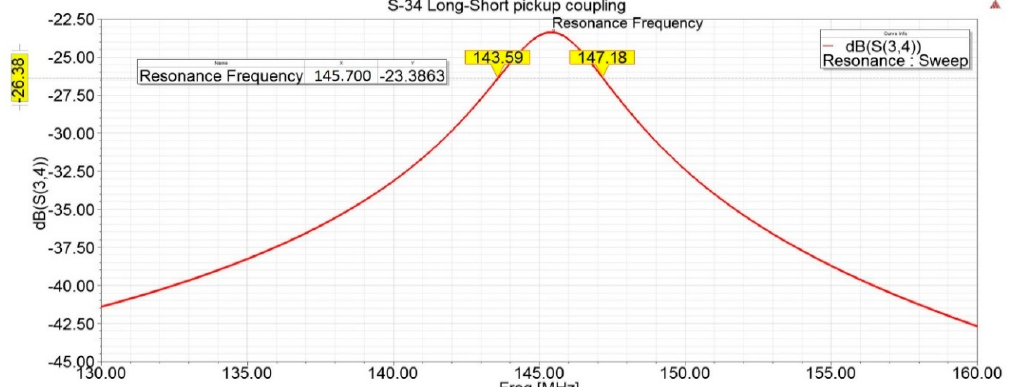
Figure 9. S-34, that is, the coupling between a long pickup and a small pickup. The resonator is tuned to 145.7 MHz (design criteria) and the simulated loaded Q is 40.58.